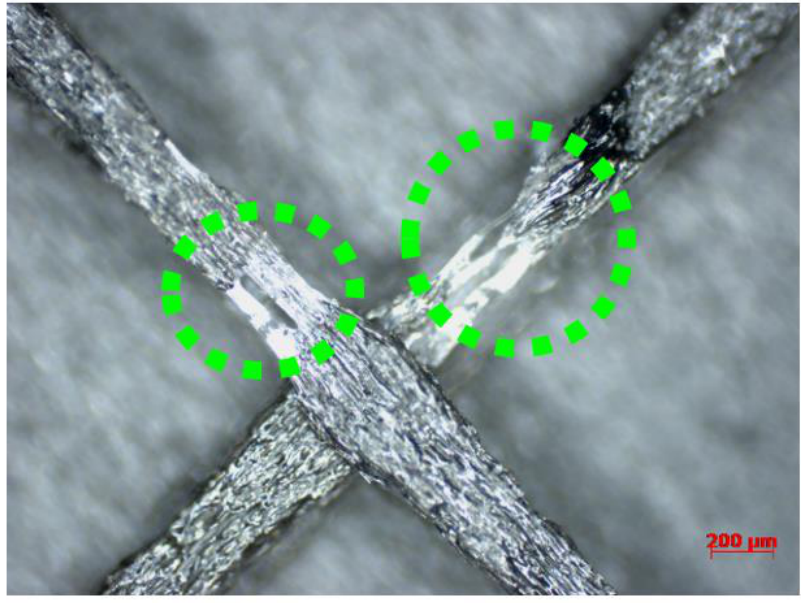
Figure 5. Narrow zone of deposited CF-PA6 filament .